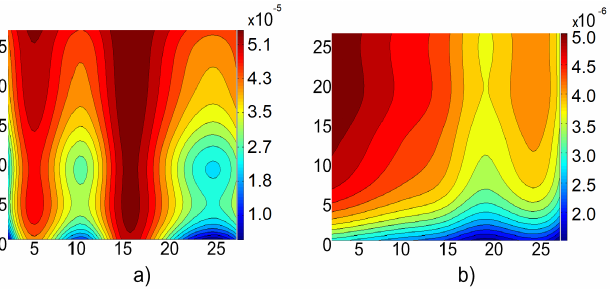
Figure 27. Isovalues curves of Leptosol’s profile. ( a ) First layer. ( b ) Second